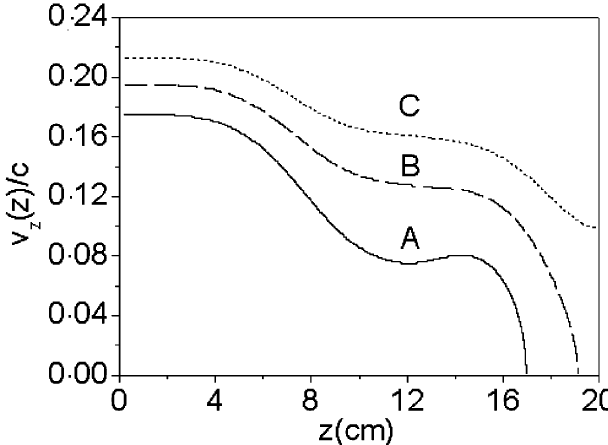
FIG. 7. Dependence of the longitudinal velocity on the longi- tudinal position: